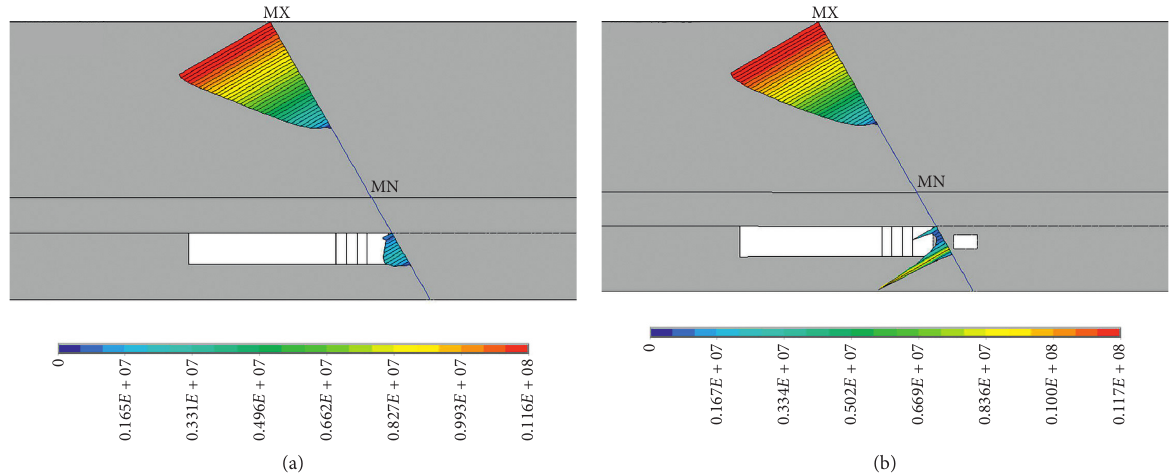
Figure 22: The nephogram of contact pressure when work face is under the fault (forward direction fault). (a) Without searching tunnel [25, 26]. (b) With searching tunnel.